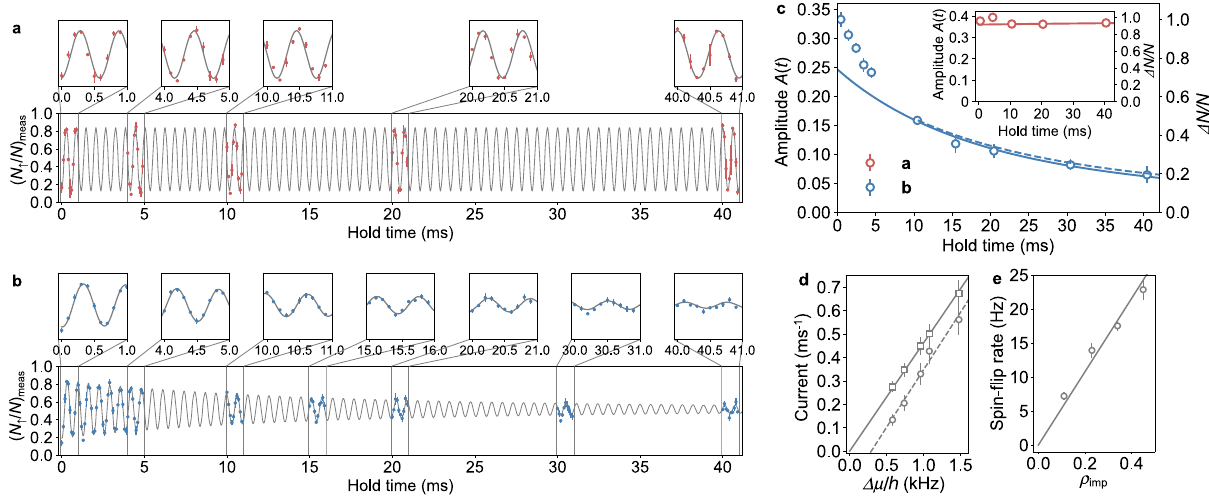
Fig. 2 Demonstration of spin-space quantum transport induced by an atomic QPC. a , b Time evolution of measured up-spin fraction ð N " = N Þ meas at 45 Gauss: a in the absence of or ( b ) in the presence of the e j i atoms, with ρ imp = 0.45. Note that the spin-up and spin-down populations are not oscillating during the transport process before the second Raman pulse. Error bars show the standard deviations of three independent measurements. Solid lines represent guides to the eye by obtaining the fi ts to the data with the compensation of the magnetic fi eld drift. Each inset shows the zoom-in view of the oscillation. c Time evolution of the oscillation amplitude A ( t ) shown in ( b ). A blue solid line represents the fi t to the data after 10 ms with Eq. (9), and the corresponding values of Δ N / N = 2 N ↑ / N − 1 = A ( t )/ A ( t ) ∣ max are also given on the right vertical axis (see “ Methods ” ). A dashed line shows the numerical calculation of the transport dynamics (see Supplementary Fig. 3). The inset shows the oscillation amplitude shown in ( a ), and a red solid line shows the fi t to the data with Eq. (9). Note that the normalization factor A ( t ) ∣ max is different between the blue and red data. d Current as a function of chemical potential bias with ρ imp = 0.45. Circles show the currents extracted from the slope of the decoherence in ( c ), and a dashed line shows the linear fi t to the data. Squares are the currents obtained from I + → − = γ Δ N compensating for the fi nite impurity lifetime, and a solid line shows the linear fi t to the data. In the calculation of the chemical potential, N = 30 is used for the total number of atoms in a tube. e Impurity-fraction dependence of the spin- fl ip rate, de fi ned as (cid:1) (cid:1) the slope of the measured decay curve at the initial time d A ¼ (cid:2) γ A 0 . Error bars in ( c – e ) are 1 σ con fi dence intervals of the data fi ts. d t t ¼ 0